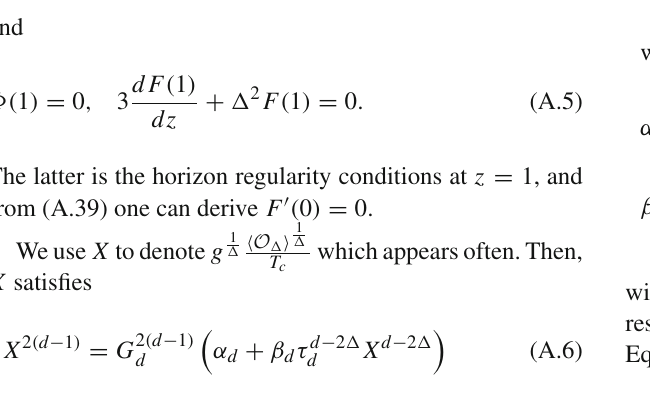
Fig. 11 Plots of α 3 , β 3 and G 3 in Eq. (A.40) over 1 / 2 < (cid:2) < 3